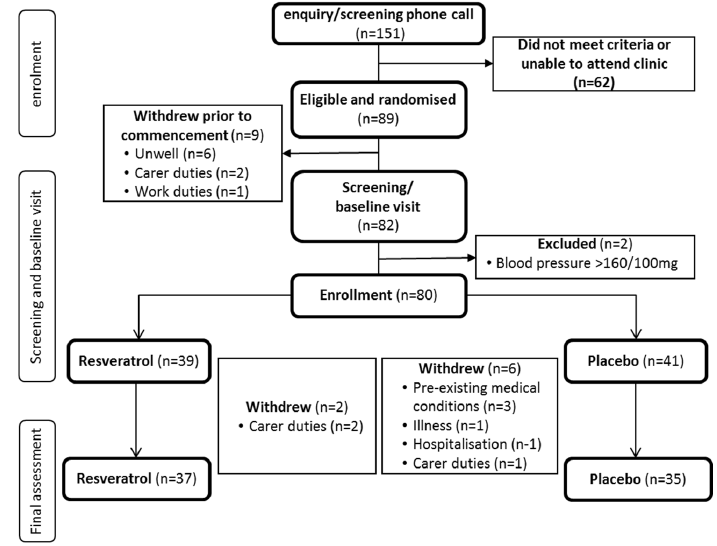
Figure 1. CONSORT diagram. Flow of participants from initial contact until final assessment.